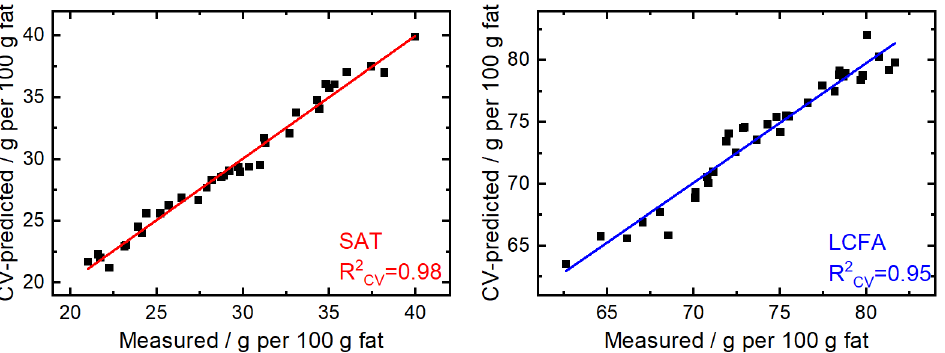
Figure 2. Measured (GC-MS) vs. predicted (ATR-FTIR, cross-validation) fatty acid concentration for the sum parameters of saturated fatty acids (SAT, left ) and long-chain fatty acids (LCFA, right ). The number of available samples can significantly influence the quality of PLS